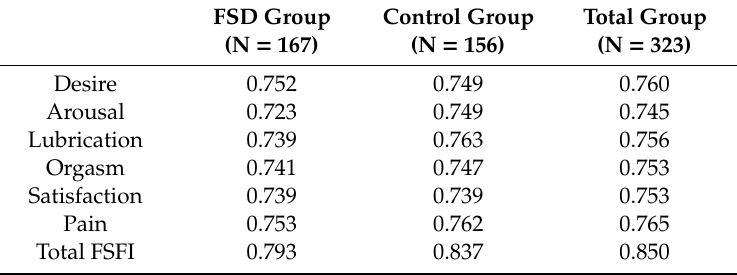
Table 3. Internal consistency reliability for dimensions and total FSFI (Cronbach’s Alpha).